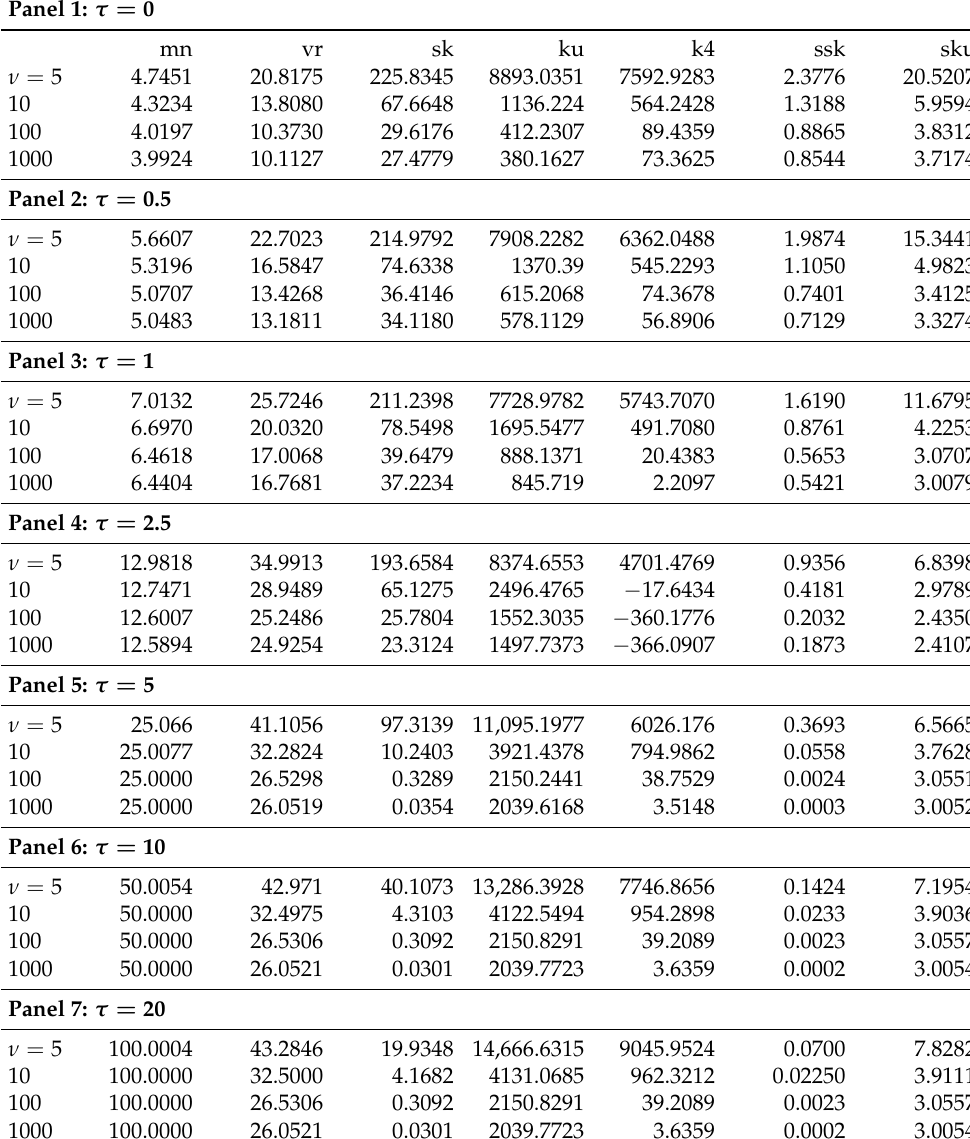
Table 9. Extended skew-Student moments, λ = 5 , τ ≥ 0